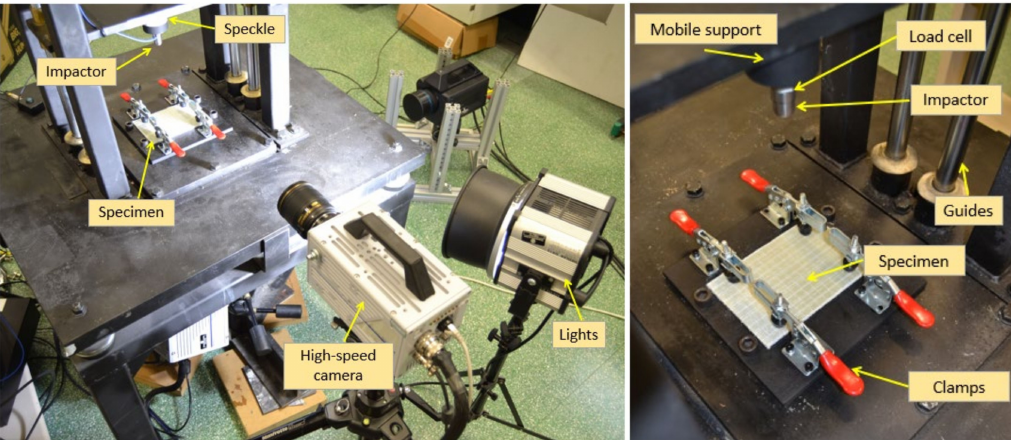
Figure 4. Setup for impact tests using the 2 m height impact test